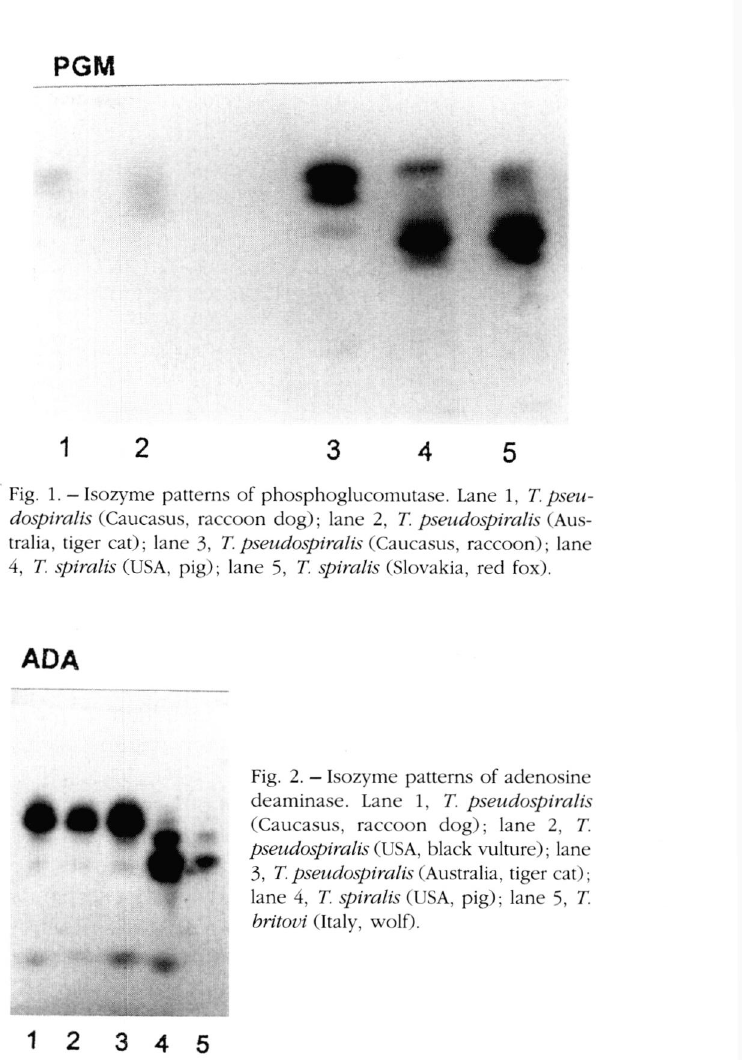
Fig. 3. - Isozyme patterns of este rase. Lane 1, T. pseudospiralis (Caucasus, raccoon dog); lane 2, T. pseudospiralis (USA, black vul ture); lane 3, T. pseudospiralis (Australia, tiger cat); lane 4, T. spiralis (USA, pig) ; lane 5, T. bri tovi (Italy,